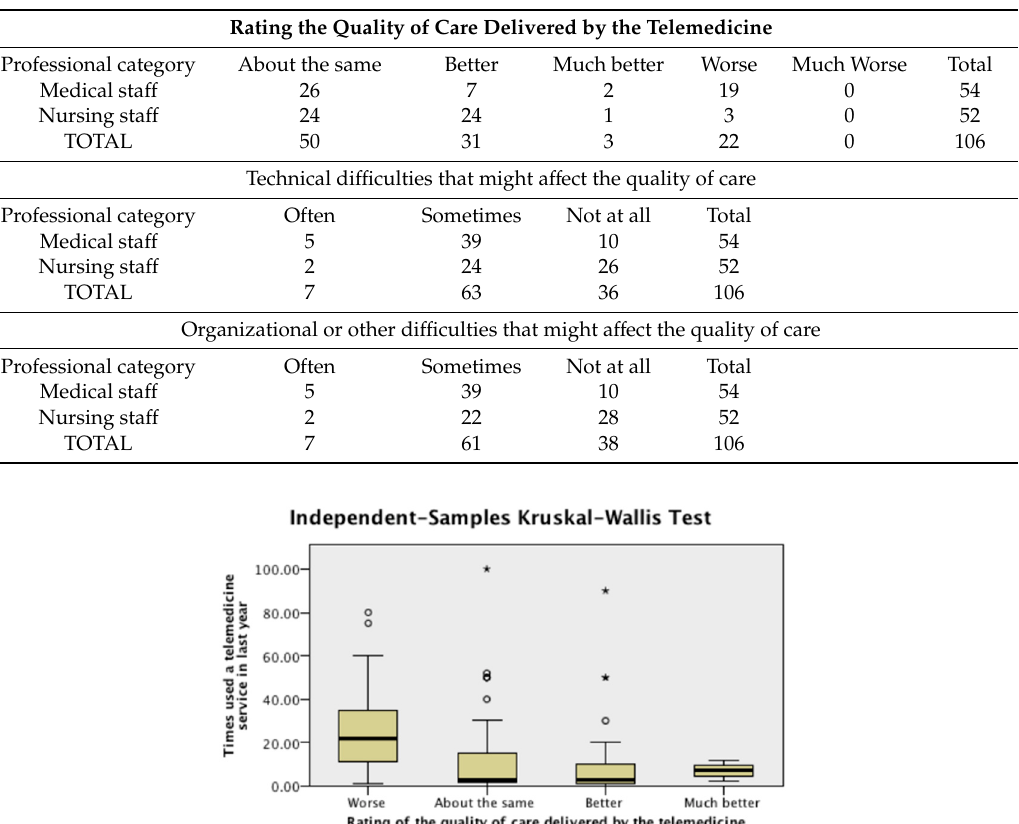
Table 3. Di ff erences in Responses by Professional Categories.